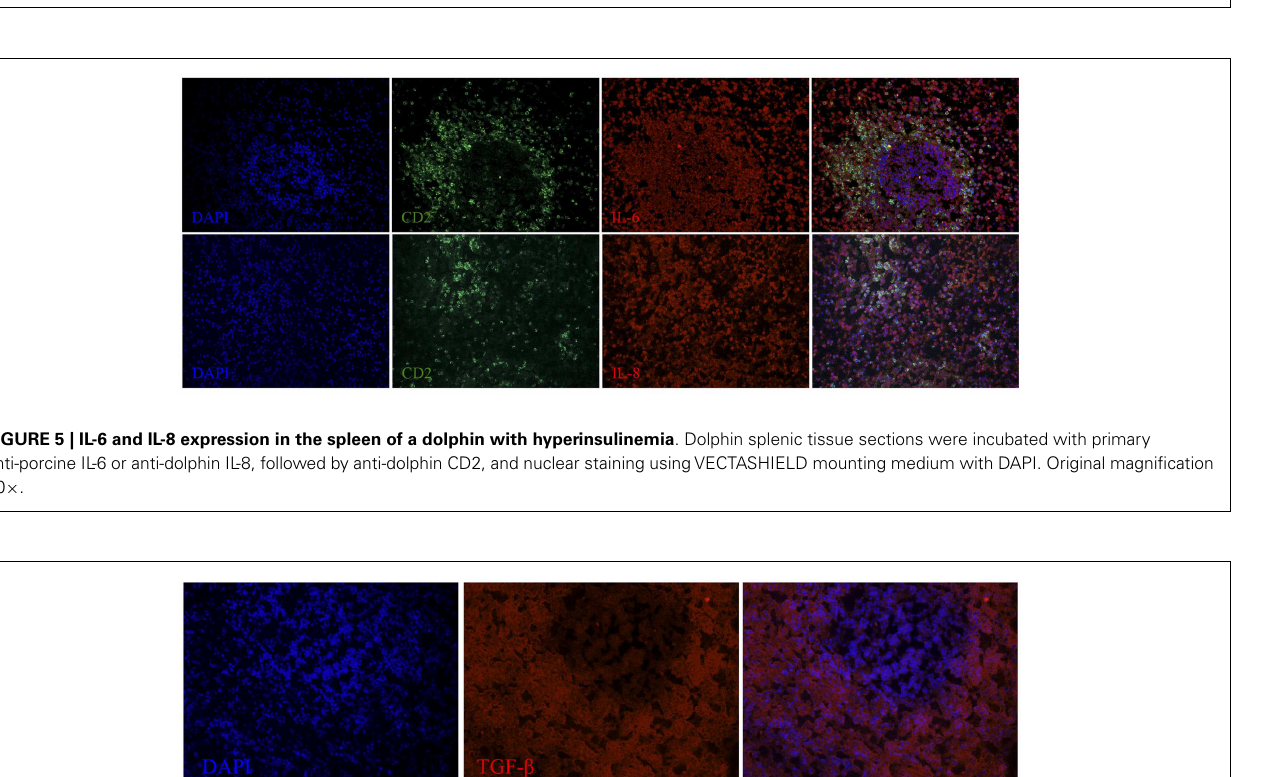
FIGURE 4 |A germinal center, surrounded by aT-cell zone, in the spleen of a dolphin with hyperinsulinemia . Dolphin splenic tissue sections were incubated with primary anti-Ki67, followed by anti-dolphin CD2, and nuclear staining usingVECTASHIELD mounting medium with DAPI. Original magnification 20 × .